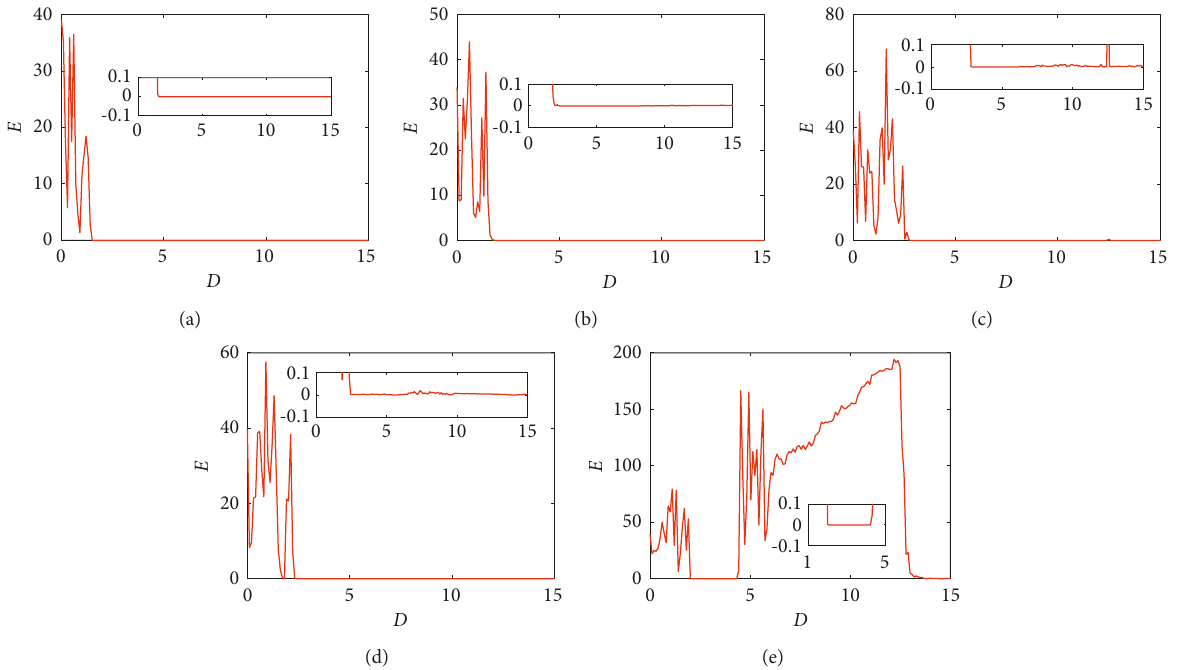
Figure 17: The synchronization errors of the coupled model with respect to coupling strength at case 6 (periodical and bursting neurons). For (a) τ � 0 . 01; (b) τ � 0 . 1; (c) τ � 0 . 3; (d) τ � 0 . 5; and (e) τ � 3. Partially enlarged interval for partial synchronization, and the initial values are selected with (0.1, 0.01, 1.05, 0.1, 0.01,